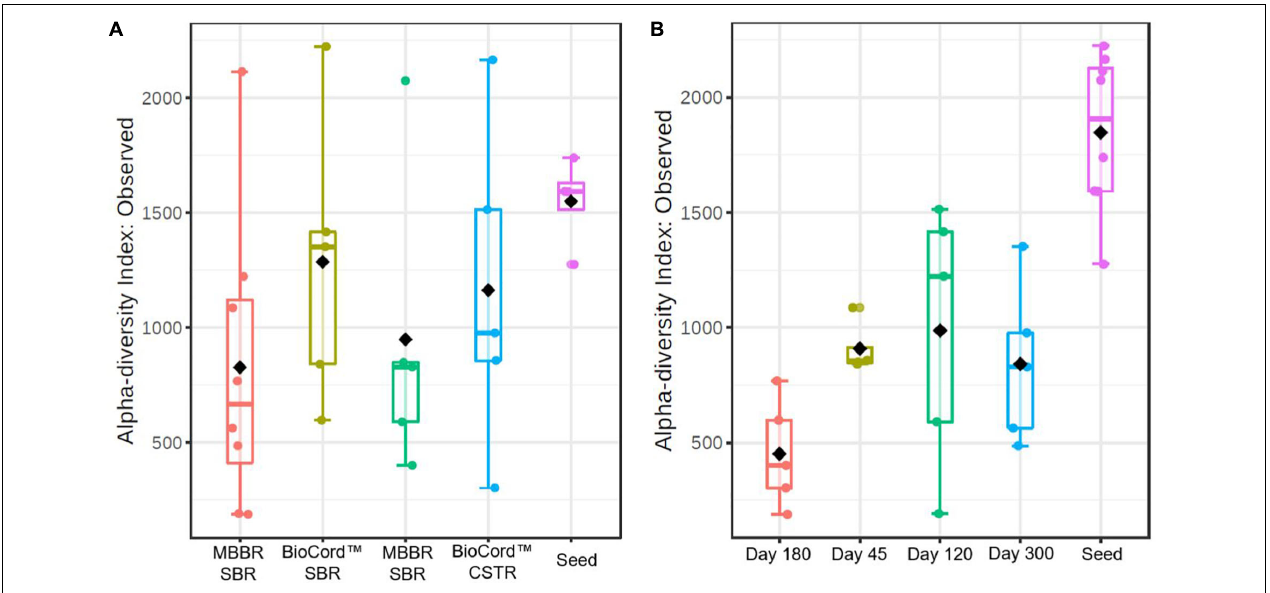
FIGURE 3 | The box plots showing alpha diversity in hybrid and fixed film bioreactors (A) , and during the operation of the bioreactors at different time points (B) .